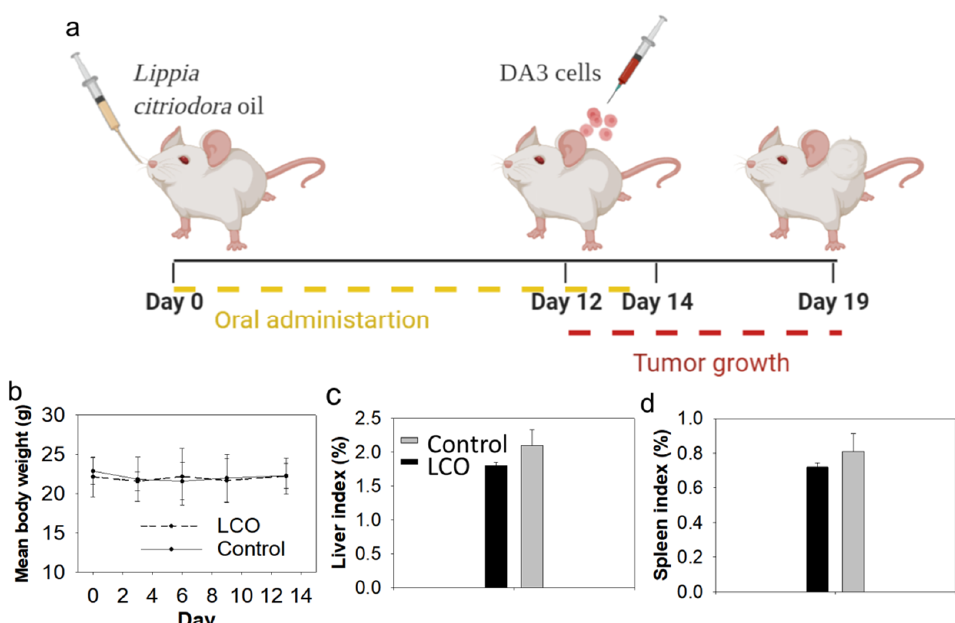
Figure 4. Orally administered LCO in mice is well tolerated. ( a ) LCO was administered daily to BALB/c mice by oral gavage for 14 days (0.552 g/kg body weight/day). On the 12th day, mice were inoculated subcutaneously with DA3 cancer cells (5 × 10 6 cells per mouse) and, 7 days later, animals were euthanized. ( b ) No significant change was observed in animal body weight between LCO-treated and control mice during the LCO administration period. No significant differences were observed between ( c ) liver- or ( d ) spleen-weight-to-body-weight ratios between control and LCO-treated mice.